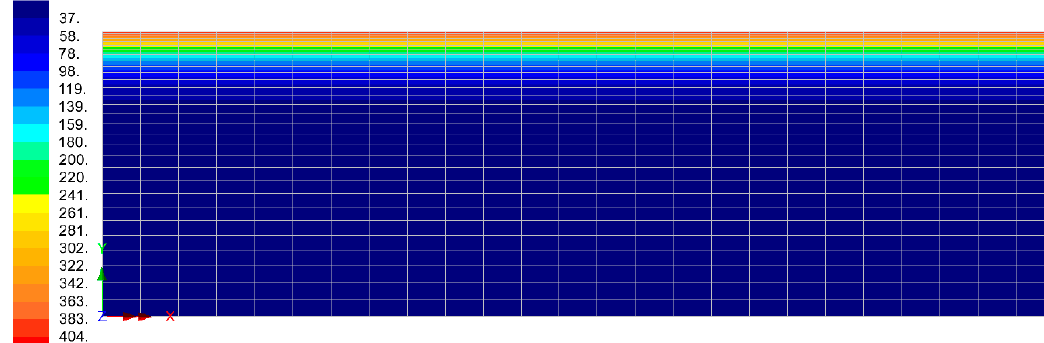
Figure 14. Roof slab (300 mm thick). Temperature distribution at time 2400 s.